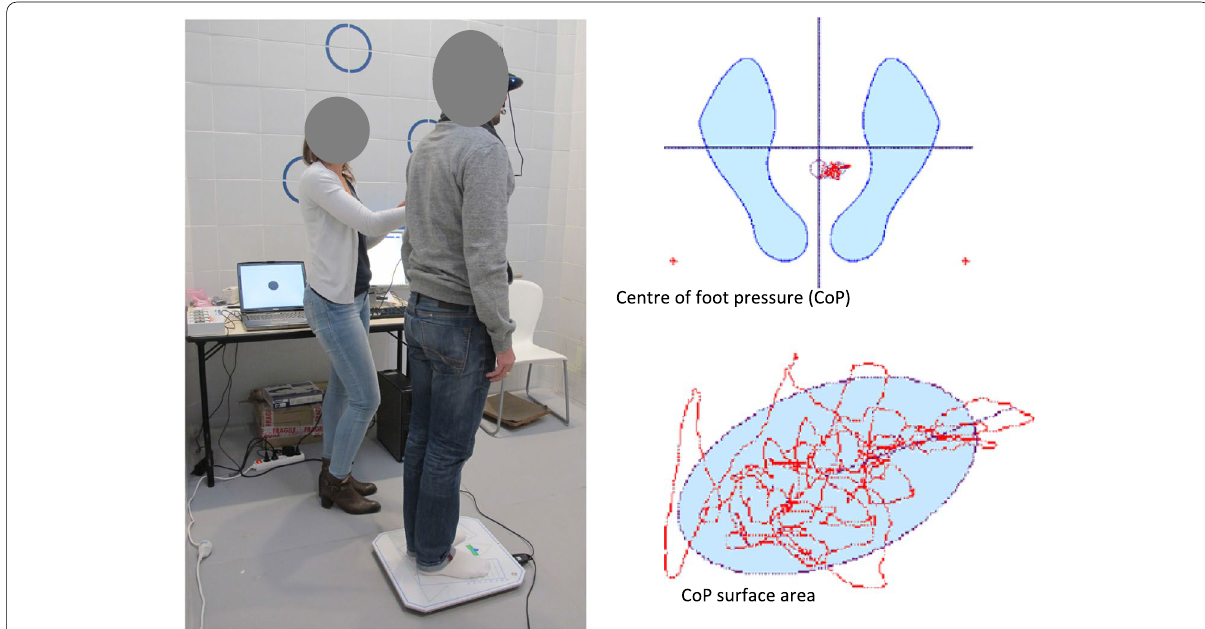
Fig. 1 Representation of the posturography measurements used in the study. The patient stands on the posturography platform (left), and the center of foot pressure of both feet (CoP) is recorded (top right). The area covered by the CoP sway path (confidence ellipse covering 90% of the points; bottom right) is then